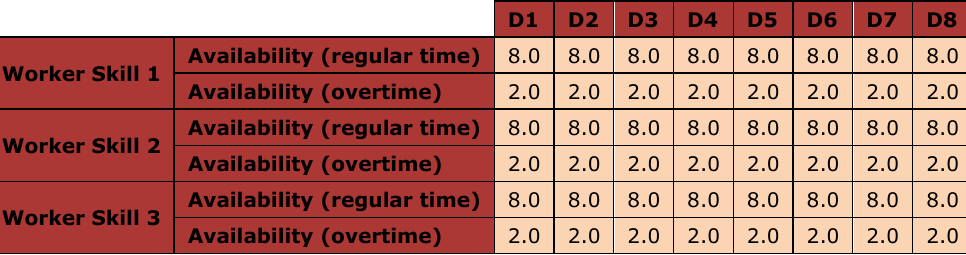
Table 3. Workers’ Availabilities